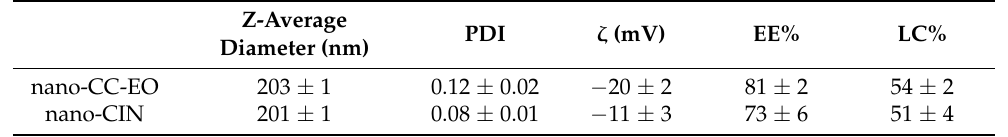
Table 1. Physicochemical characterization of nano-CC-EO and